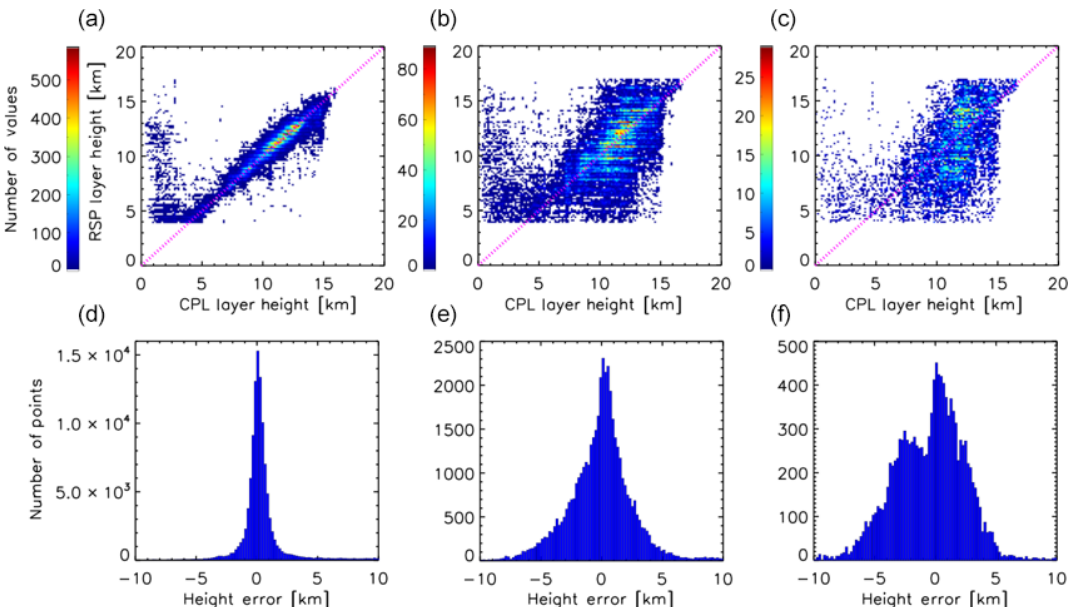
Figure 11. Comparison of CTH retrieved using the RSP 1880nm band and CPL for the primary peak (top left), second peak (top middle) and third peak (top right) with their associated error distributions immediately below each scatterplot. Here, filters detailed in Table 4 are applied.